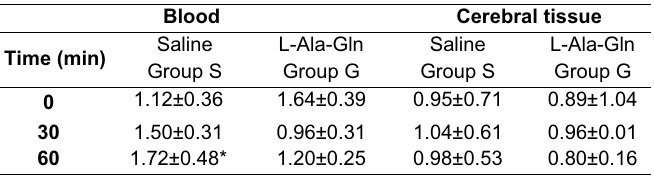
TABLE 1 - Glucose concentrations in blood (µmol/mL) and cerebral tissue (µmol/g) for Group S (saline solution) and Group G (L-alanyl-L- ) and after 30 minutes (T ) and 60 minutes (T ) glutamine) before (T 0 30 60 of reperfusion. Each value is based on a group of six animals.